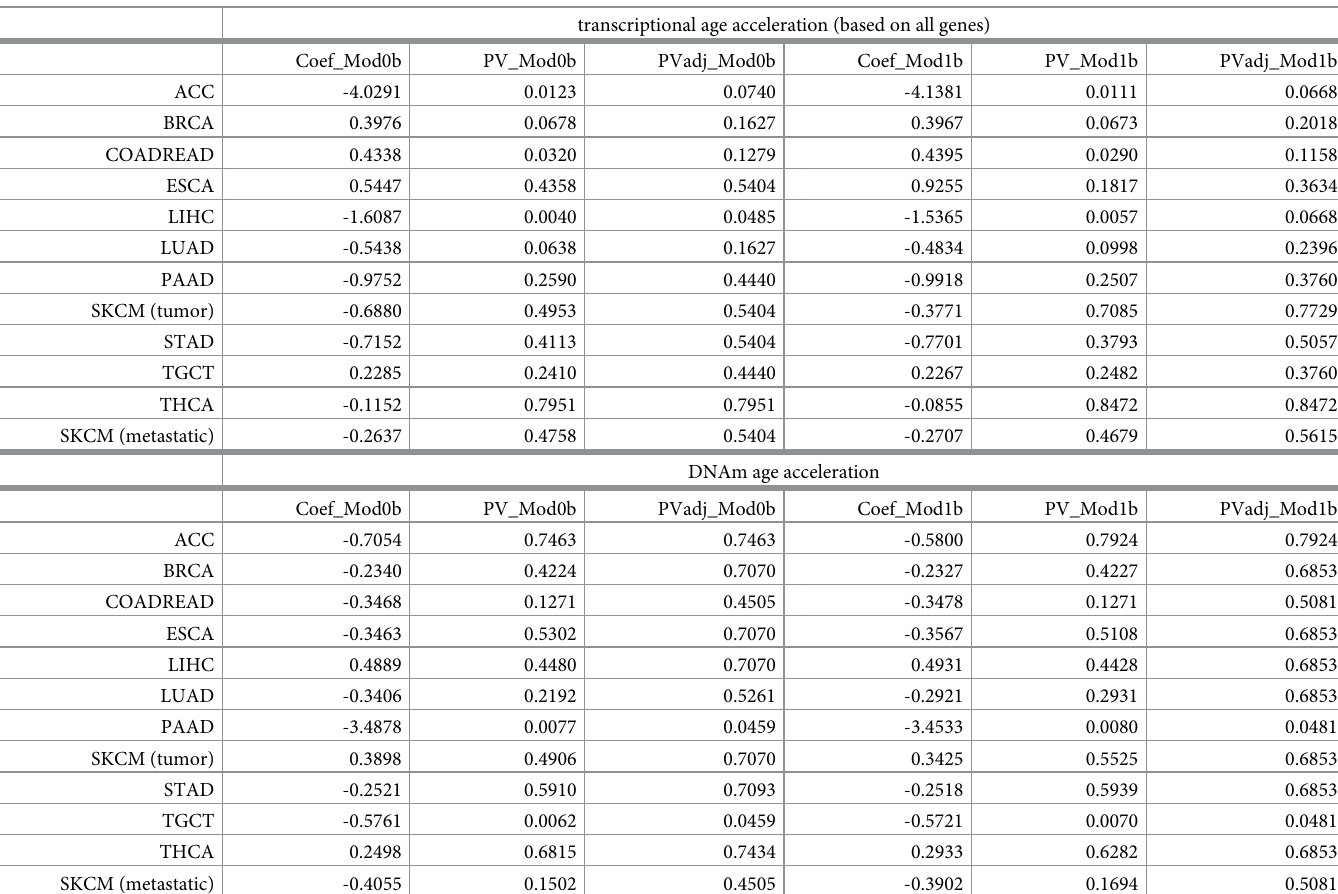
Table 4. Coefficient and p-value of age acceleration residual versus stage from linear